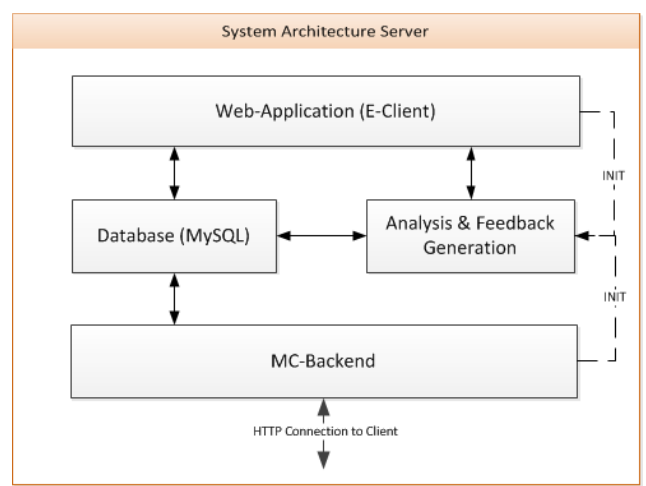
Figure 8. System architecture of the